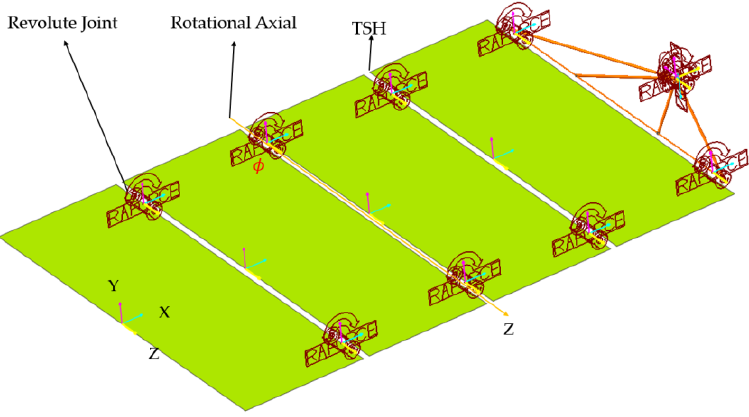
Figure 2. Modeling of tape spring hinges in RecurDyn.